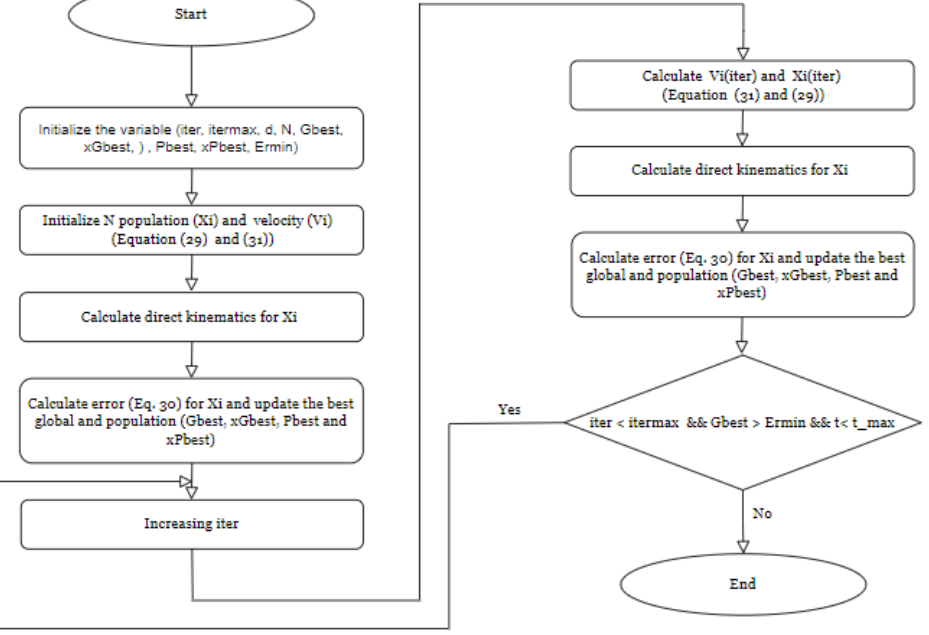
Figure 7. This pseudo code for PSO meta heuristics.